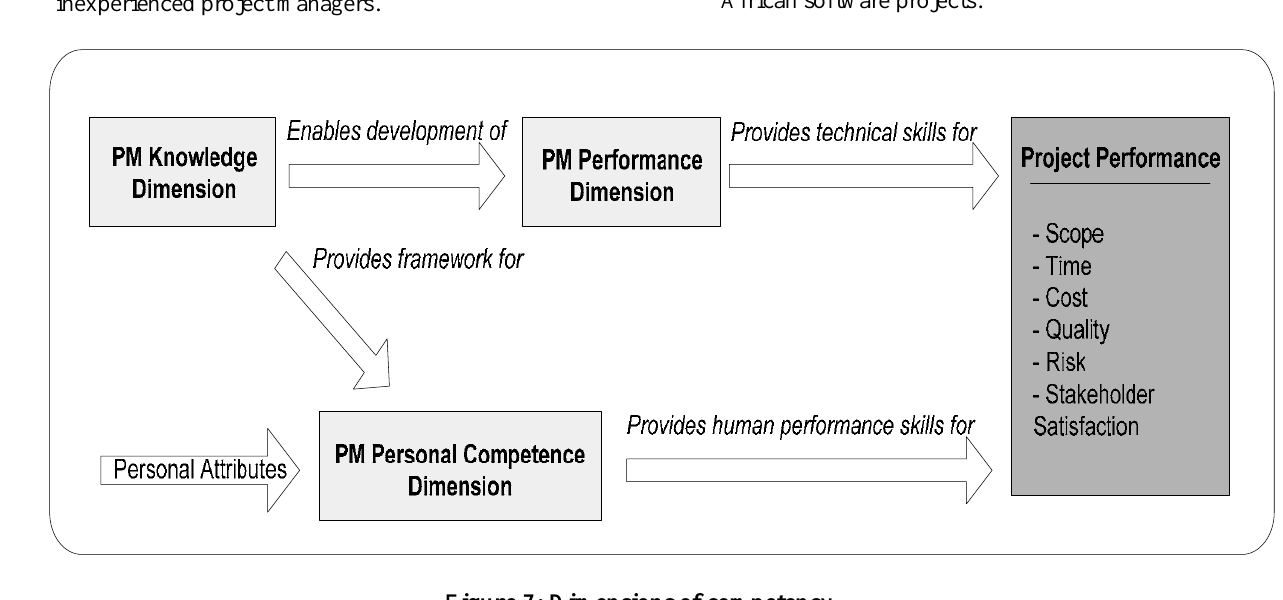
Figure 7: Dimensions of